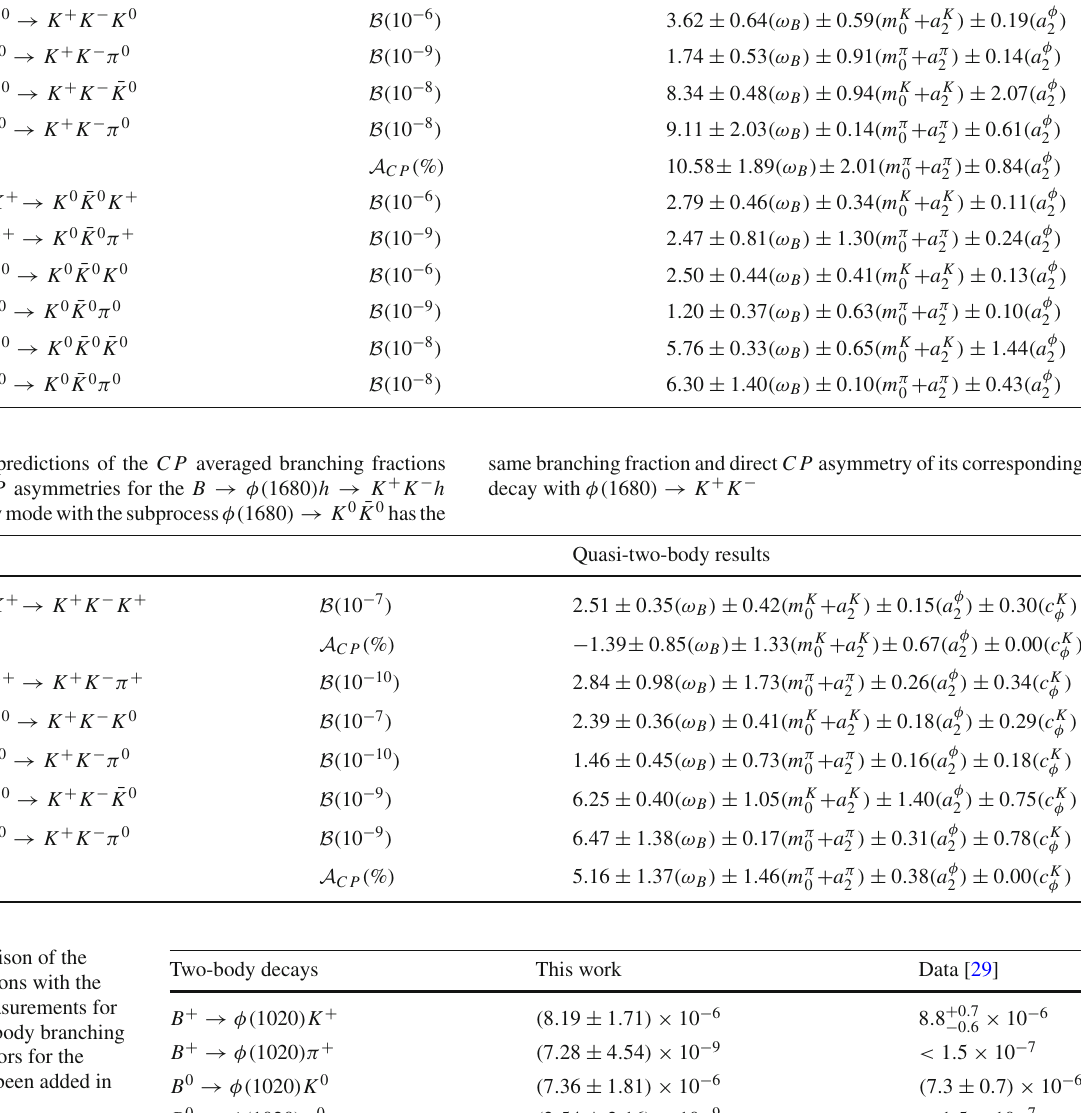
Table 4 Comparison of the extracted predictions with the experimental measurements for the relevant two-body branching fractions. The errors for the predictions have been added in quadrature